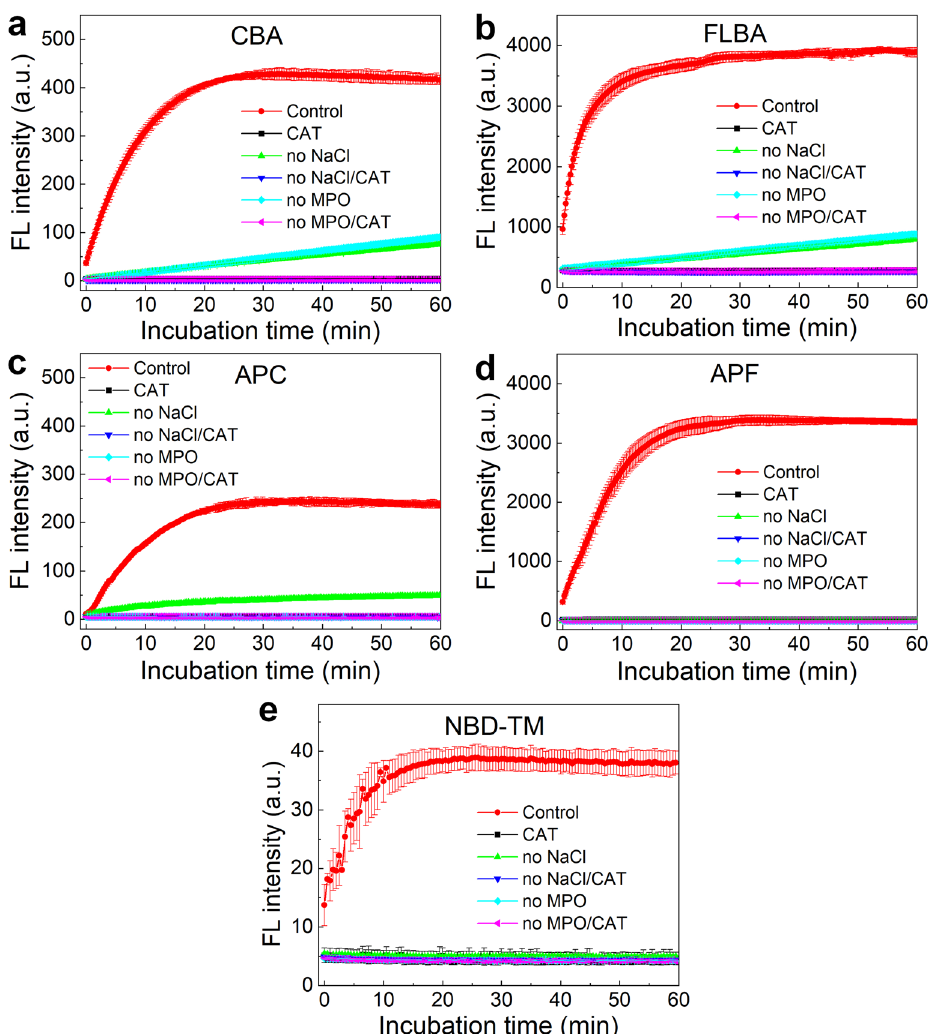
Figure 3. ( a ) Oxidation of CBA to COH in the incubation mixtures containing CBA (20 µM), MPO (1.2 nM), H 2 O 2 (10 µM), NaCl (0.1 M), and phosphate buffer (50 mM, pH 7.4) (red); in the presence of catalase (100 U/ ml, black); in the absence of NaCl (green); in the absence of NaCl but in the presence of catalase (dark blue); in the absence of MPO (light blue); in the absence of MPO but in the presence of catalase (pink). ( b – e ) same as ( a ) but instead of CBA, incubation mixtures contained FLBA, APC, APF, and NBD-TM, respectively, and were oxidized to appropriate fluorescent compounds. (Each panel is a representative result of three independent experiments. Points represent means ±